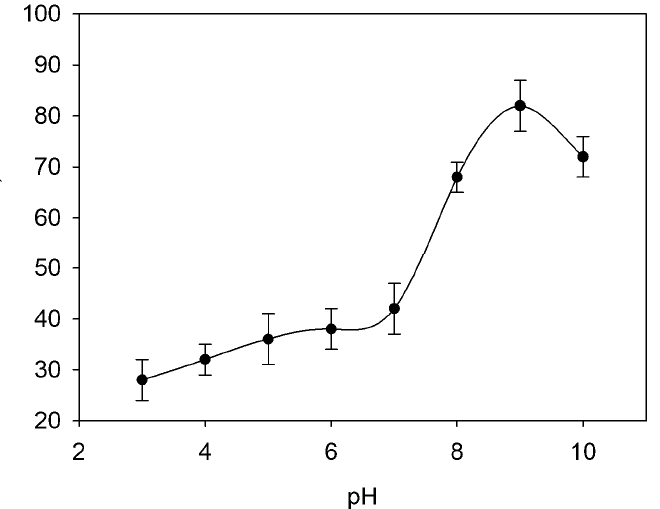
Figure 1. Effect of pH on Hg(II) retention. The error bars correspond to the standard deviation of three experiments.